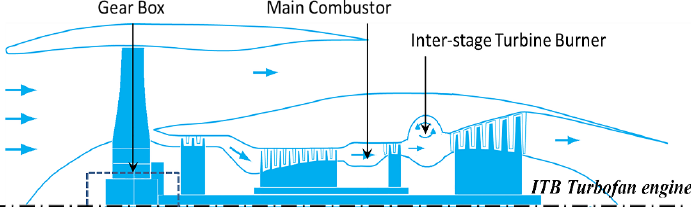
Figure 24. Schematic of the multi-fuel hybrid engine investigated in the AHEAD project. Adapted from Figure 3 of [37].